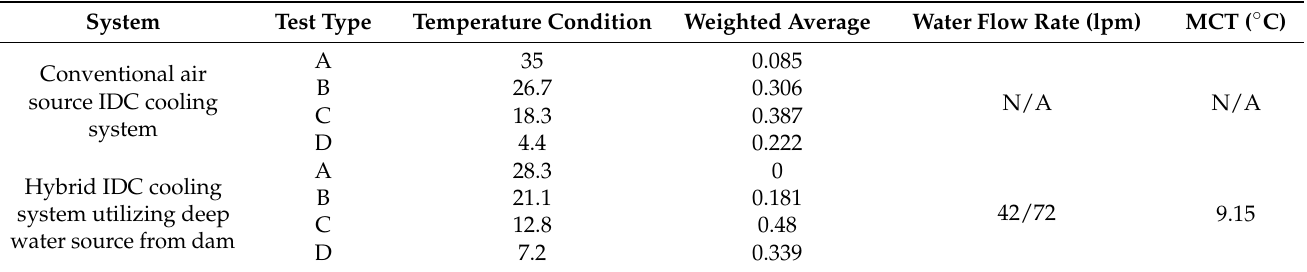
Table 7. Performance of cooling systems.